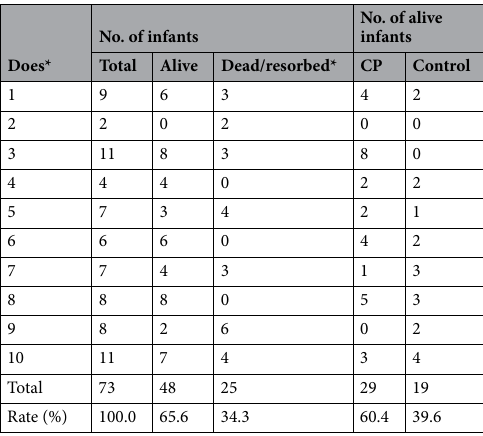
Table 1. Frequency of survival and cleft palate in offspring of pregnant does given dexamethasone for 4 consecutive days during pregnancy. *The 10 pregnant rabbits were numbered from 1 to 10. *These include aborted infants and absorbed